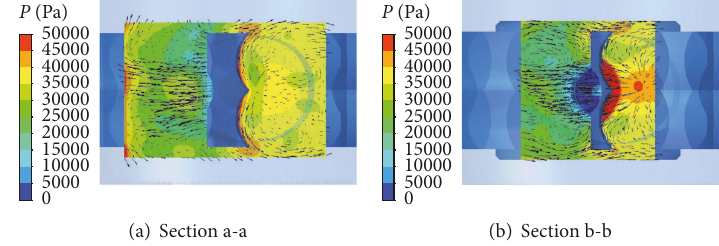
Figure 25: Static pressure distributions and absolute velocity vectors of Blade A ( 𝜃 ∗ = 48 ∘ , 𝑛 = 150 ,000 min −1 ).